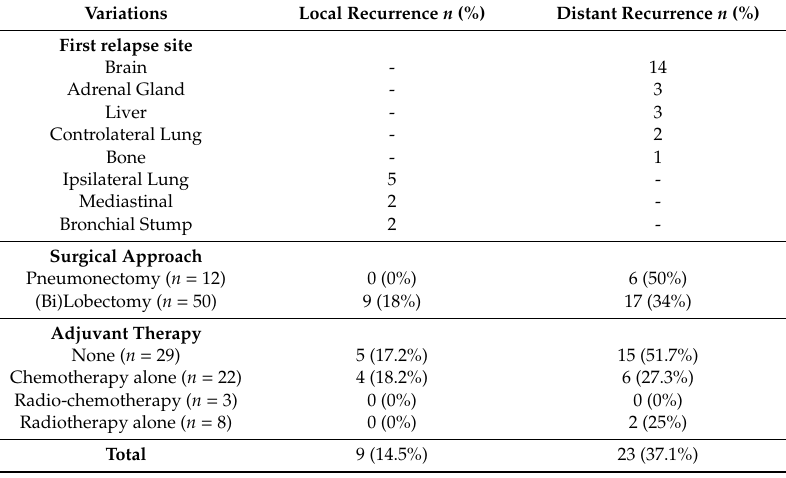
Table 2. The pattern of failure after surgery following IT in patients with